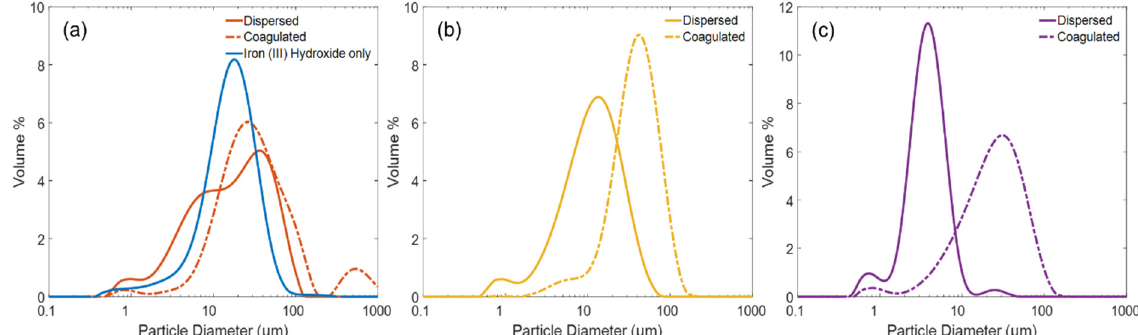
Figure 5. Particle size distributions (PSDs) for ( a ) modified bentonite, ( b ) talc and ( c ) calcium carbonate before and after coagulation with iron hydroxide. PSD for pure iron hydroxide flocs also shown in ( a ).